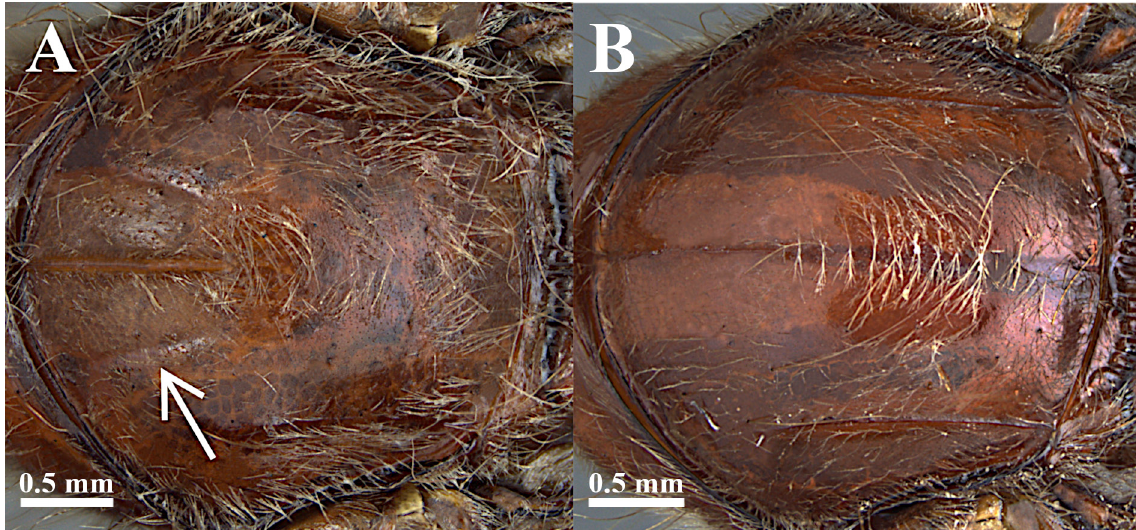
Fig. 11. A . Detail of mesoscutum with notaulus (see arrow) in Dinoponera gigantea (Perty, 1833). B . Detail of mesoscutum without notaulus in D. quadriceps Kempf, 1971. 3. Abdominal tergite VIII triangular, with a very sharp apex (Fig. 12A). Penisvalva ending in a